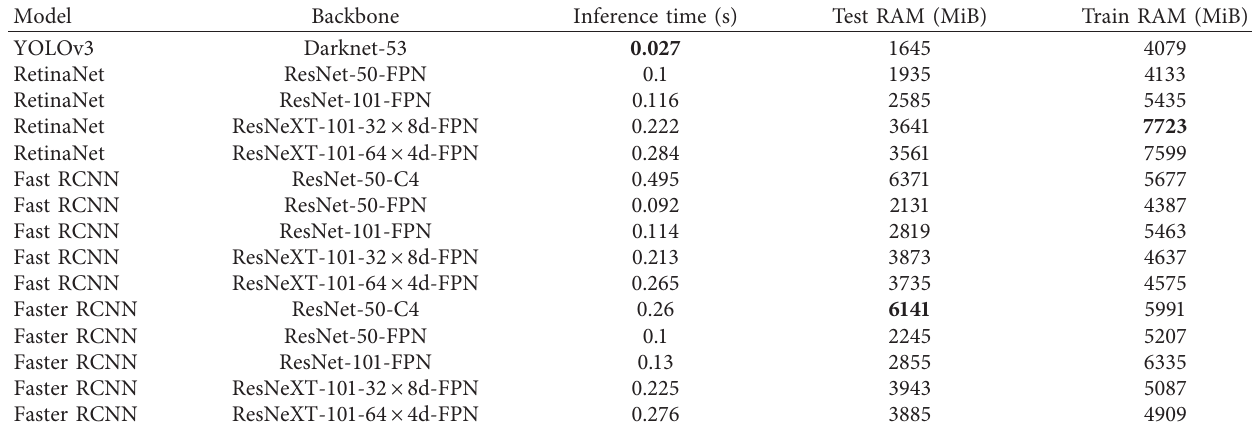
Table 6: The comparison of consumption on subsets filtered from PASCAL VOC.